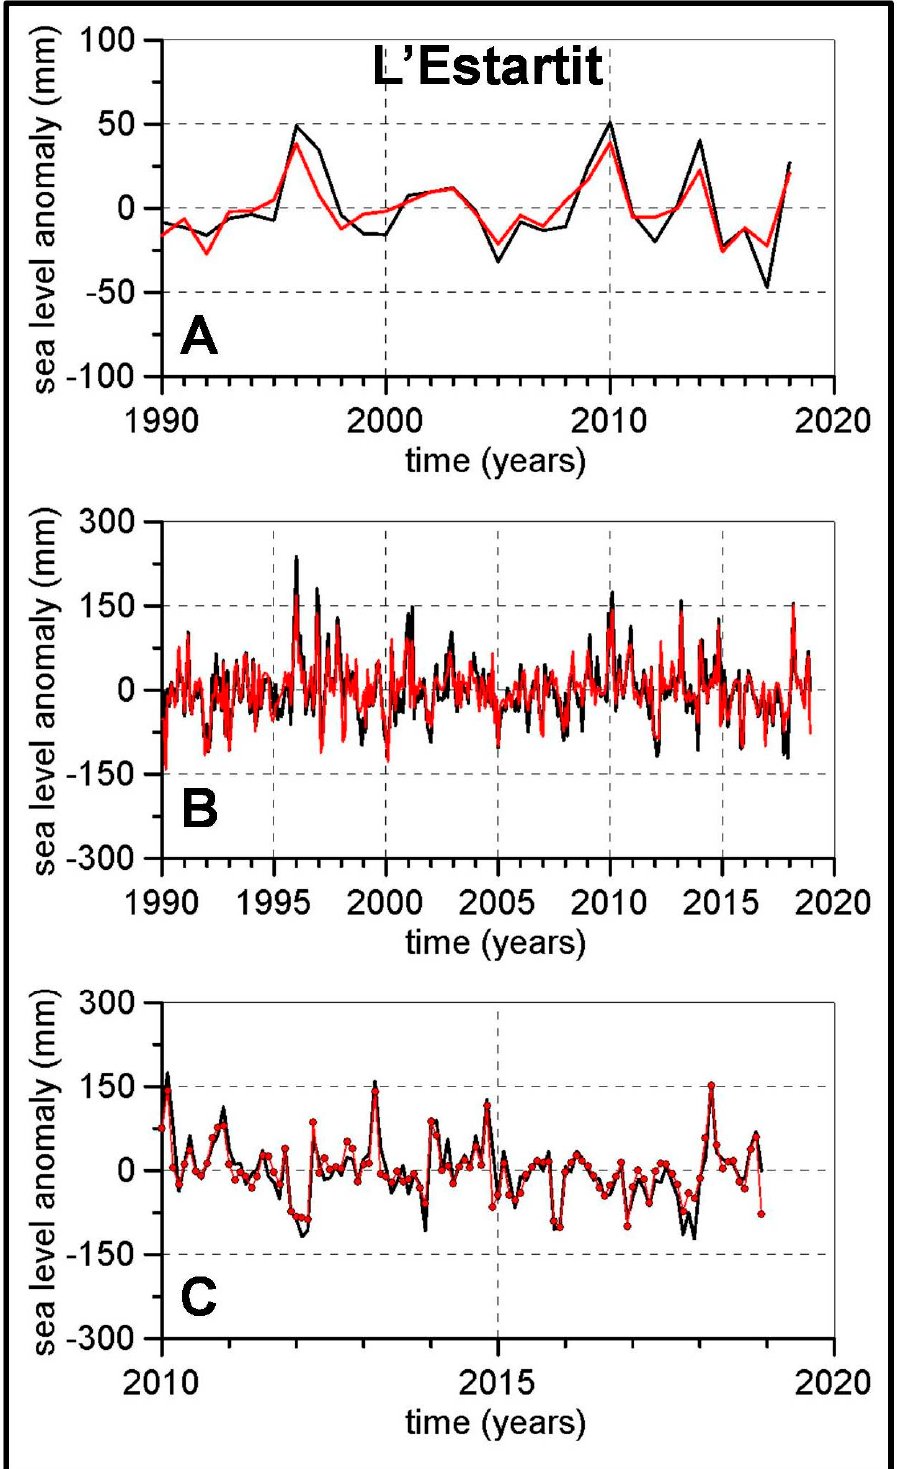
Figure 8. Observed sea level anomalies and regression from the linear model. Black lines are the observed sea level (de-seasoned and de-trended) at L’Estartit. Red lines are the values predicted by a linear model based on the atmospheric variables and the thermosteric and halosteric components of sea level (see the text and Table 4). ( A ) shows annual mean values for the period 1990–2018 and ( B ) shows monthly values for the same period. ( C ) is a zoom showing monthly values for the period 2010–2018.